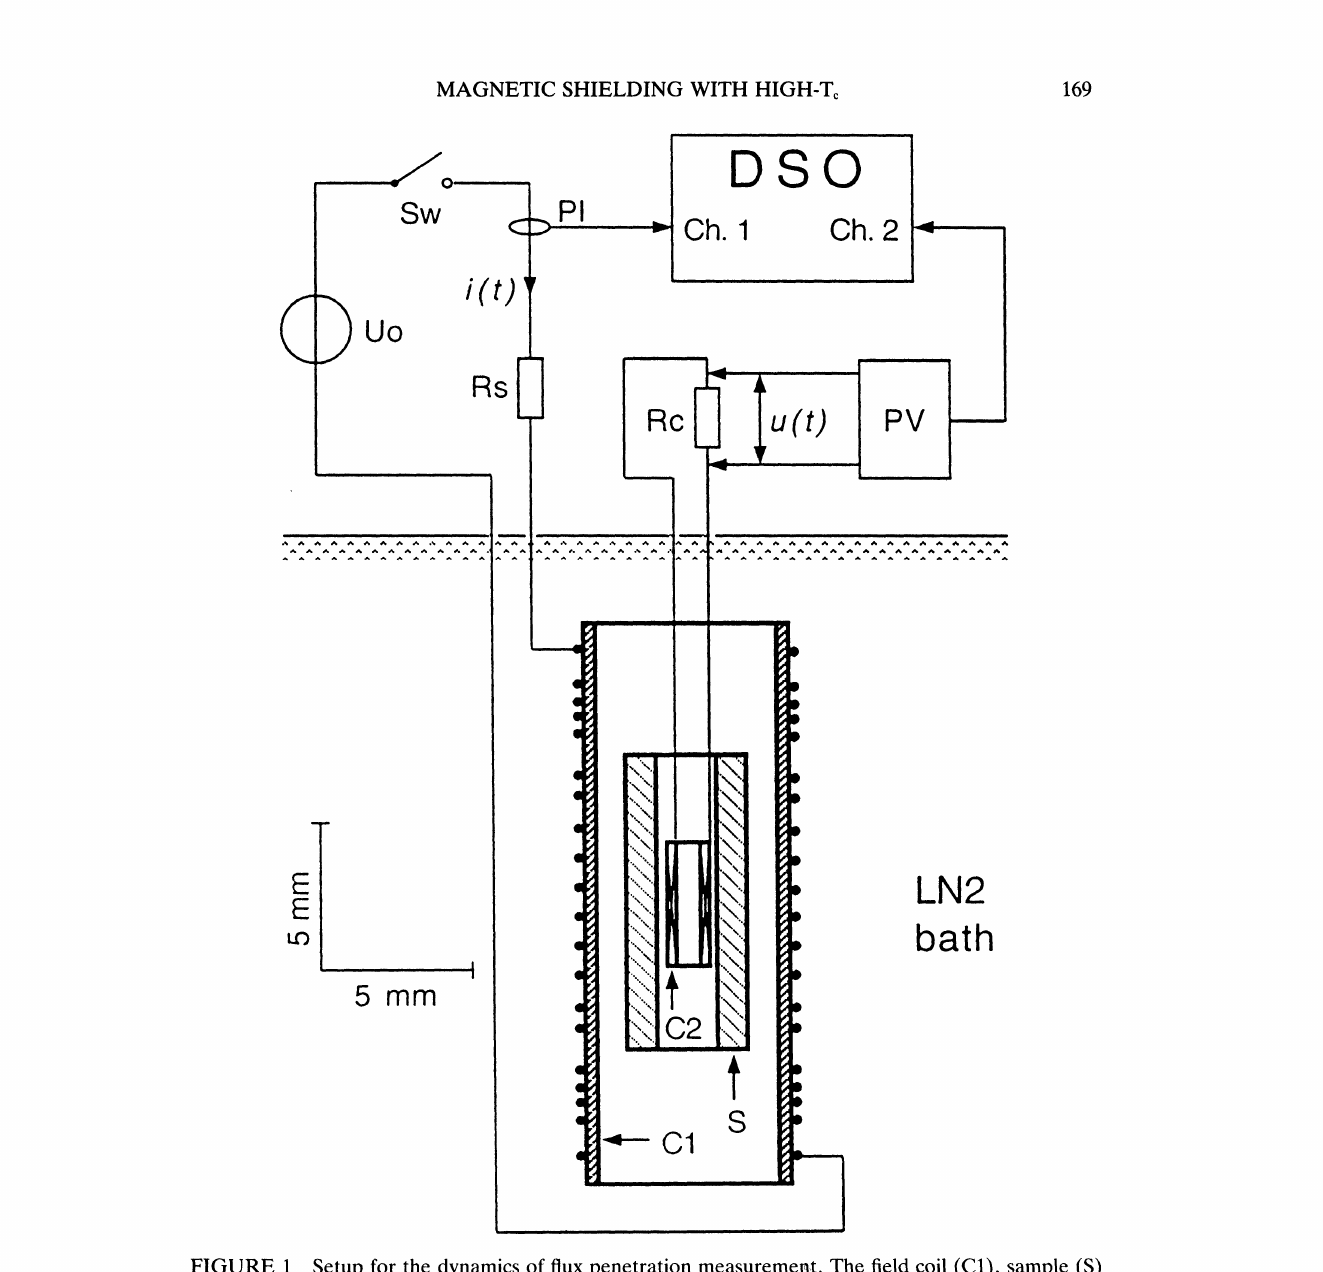
FIGURE Setup for the dynamics of flux penetration measurement. The field coil (C1), sample (S) and pickup coil (C2) assembly is shown to scale. See the text for the remaining symbols.